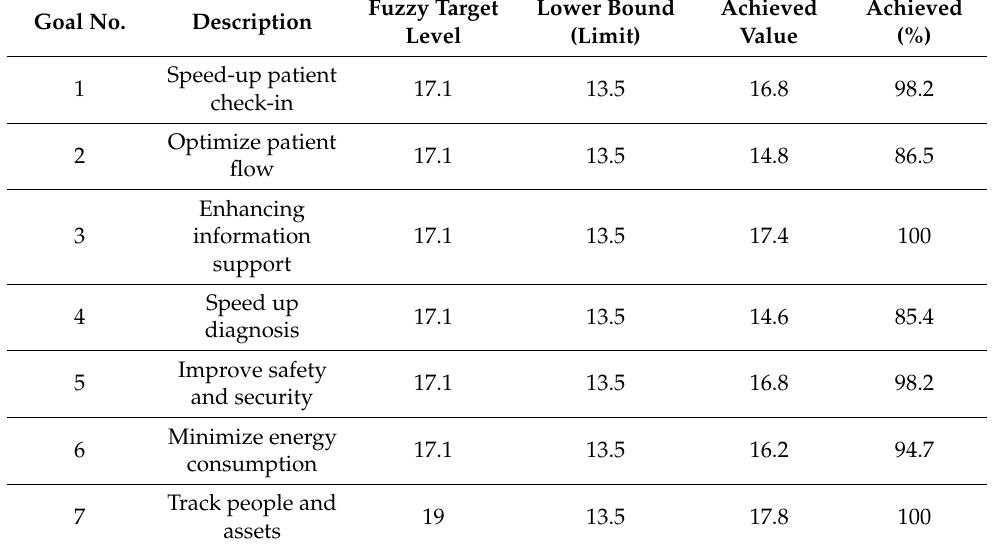
Table 9. Analysis of goal